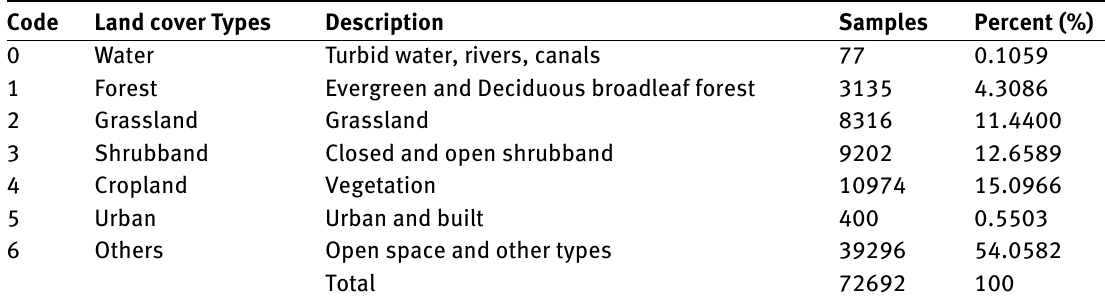
Table 2: A detailed classification scheme experimented in our segmentation approach on chosen study area